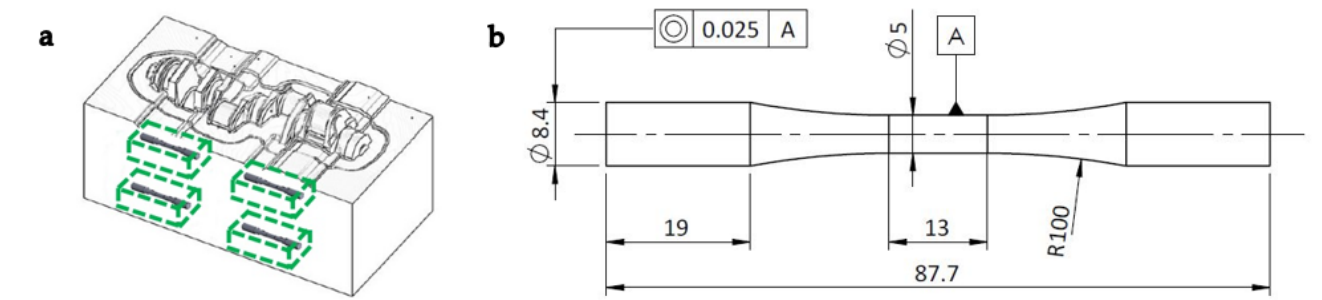
Figure 1. Origin of the steel specimens: ( a ) extraction of blocks from the crankshaft die and ( b ) speci- men dimensions in millimetres after machining of the blocks.